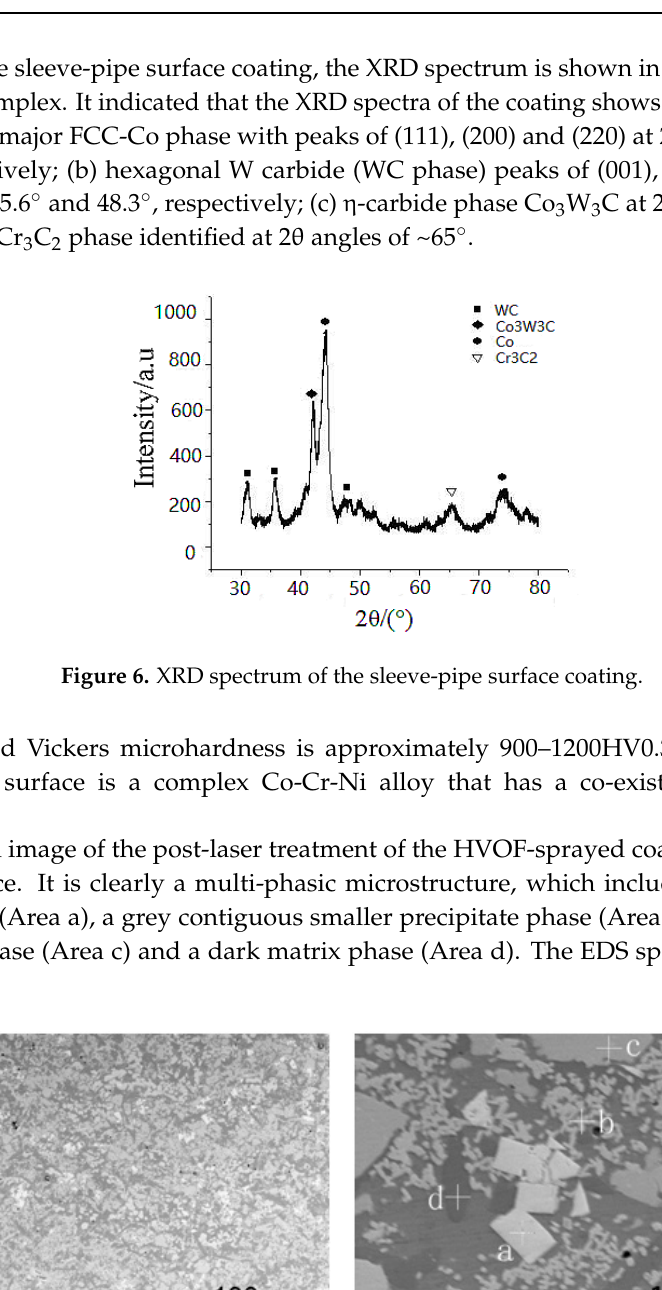
Figure 7. Post ‐ laser treatment of the HVOF ‐ sprayed coating on the sleeve ‐ pipe surface: ( a ) cross ‐ section of treated coating; ( b ) position of EDS.